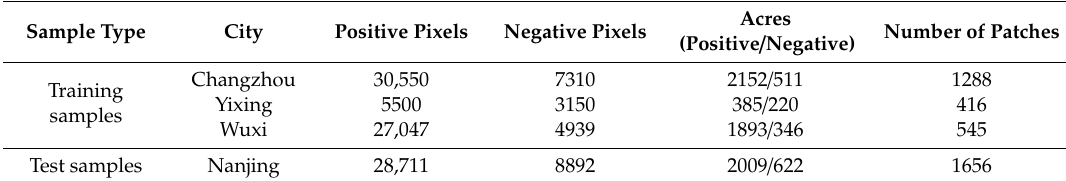
Table 2. Specific information on the training and test samples.